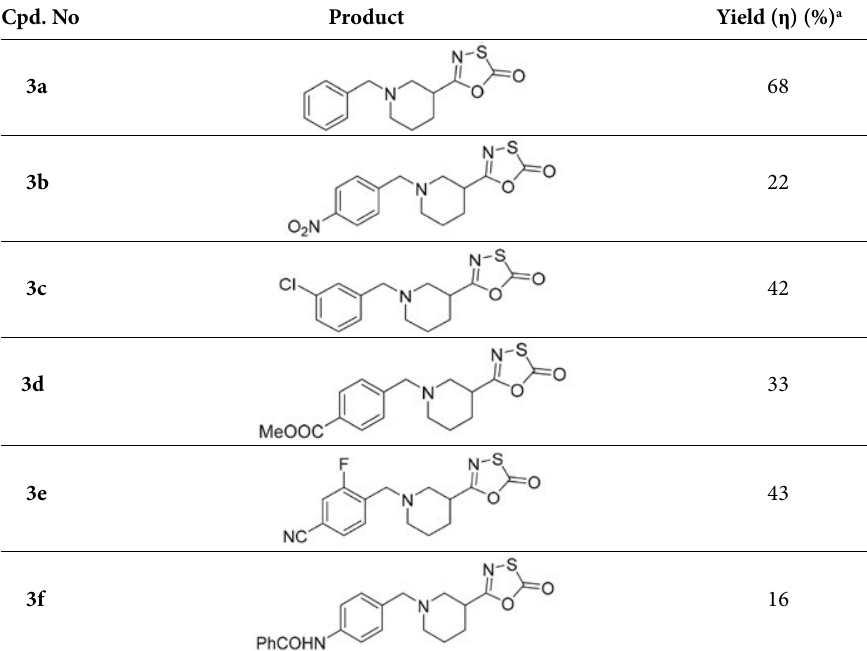
Table 1. Synthesis of piperidin-3-yl-oxathiazol-2-ones 3a – f . Cpd.